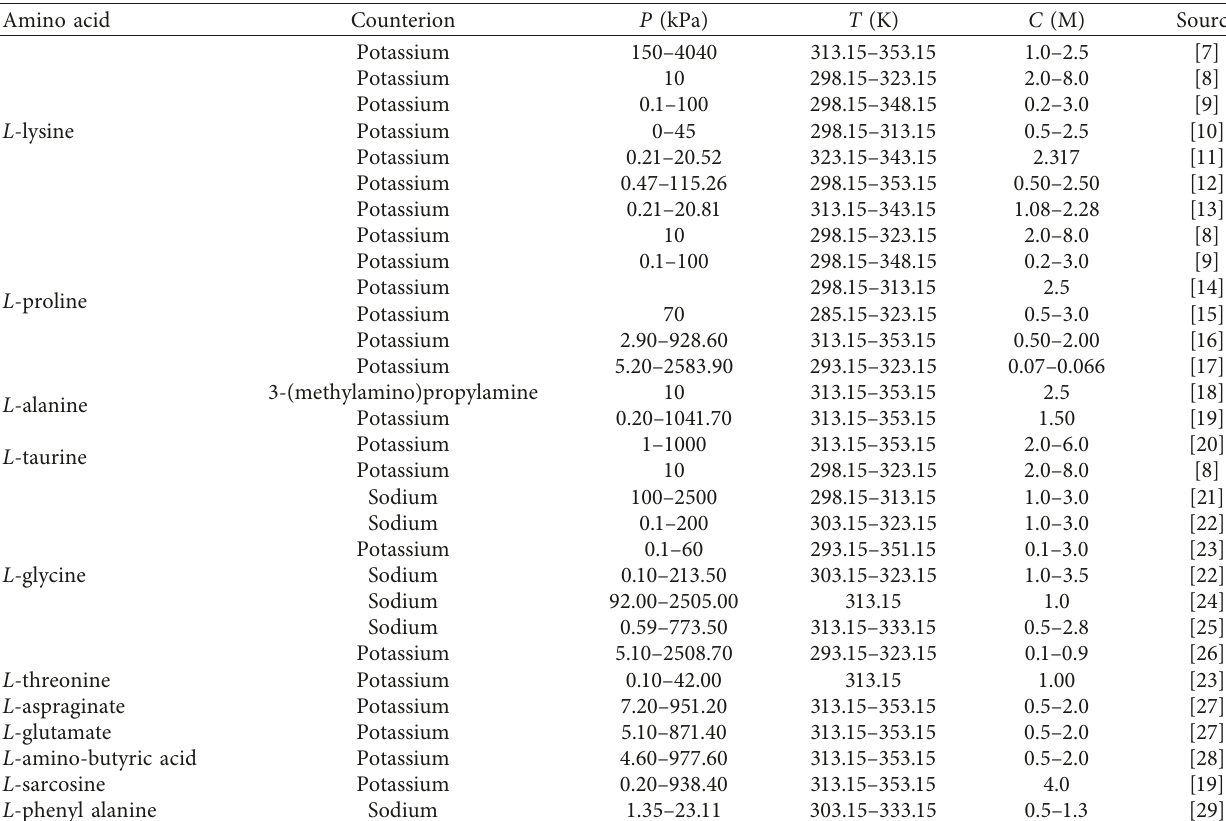
Table 1: Sources of experimental data for carbon dioxide solubility in various aqueous amino acid salt solutions.